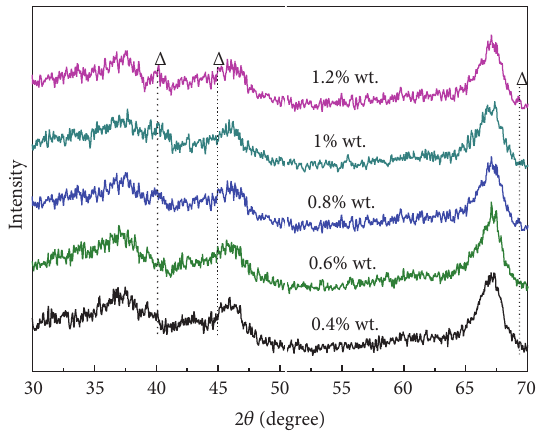
Figure 7: The XRD patterns of different loadings of Pd/Al 2 O 3 .